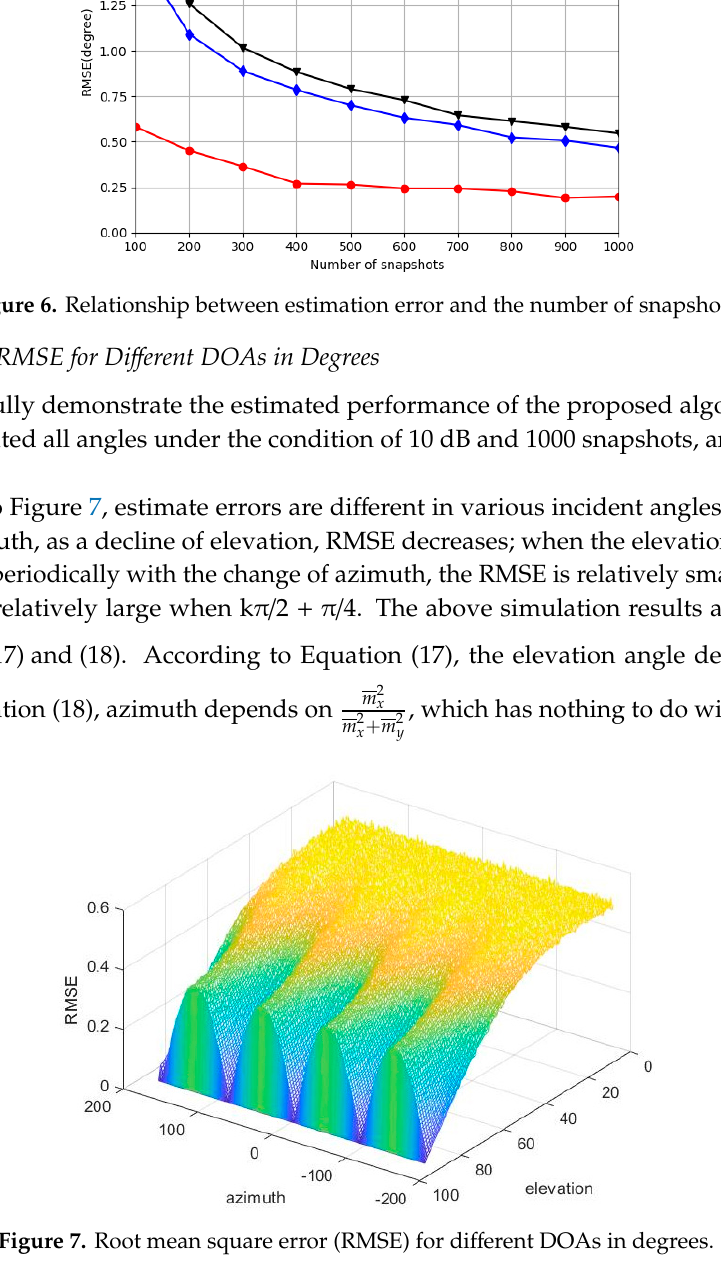
Figure 6. Relationship between estimation error and the number of snapshots.